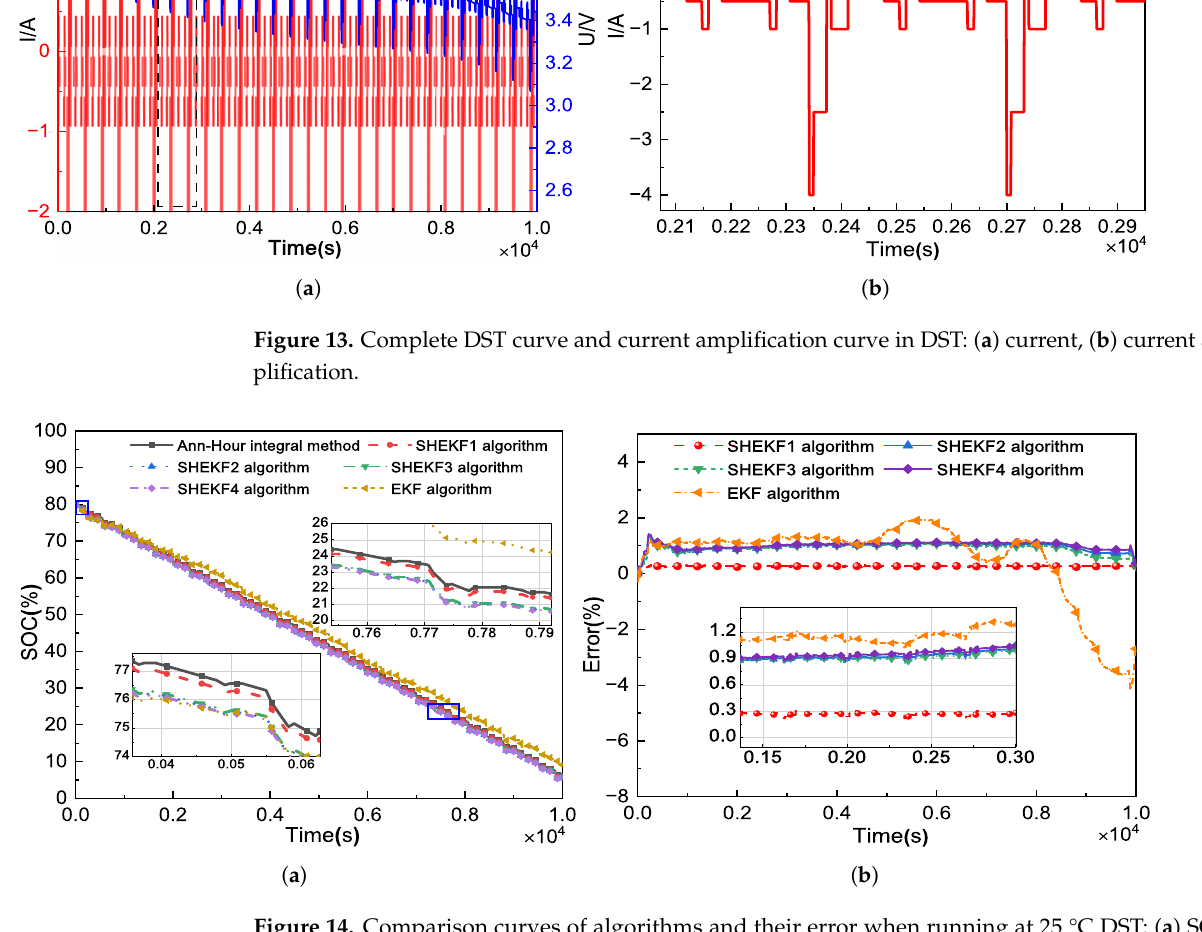
Figure 14. Comparison curves of algorithms and their error when running at 25 °C DST: ( a ) SOC, ( b ) Error. Table 5. RMSE and MAE under 25 °C DST condition